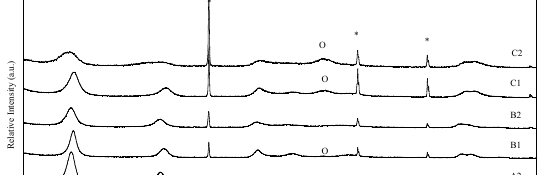
, B- Mg/ 65 Figure 6. SEM micrograph of as-synthesized Mg/Al/Ni LDH.